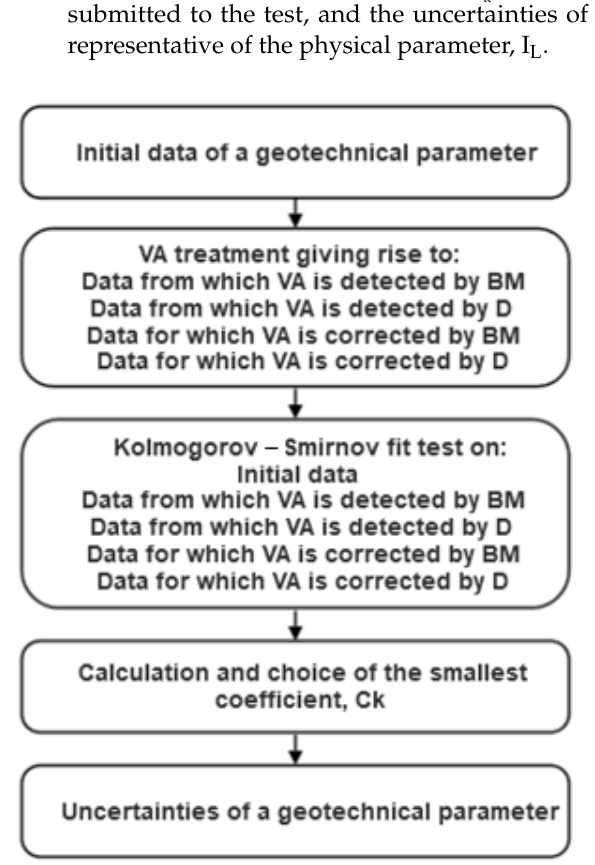
Figure 6. Determination of uncertainties of a geotechnical parameter.